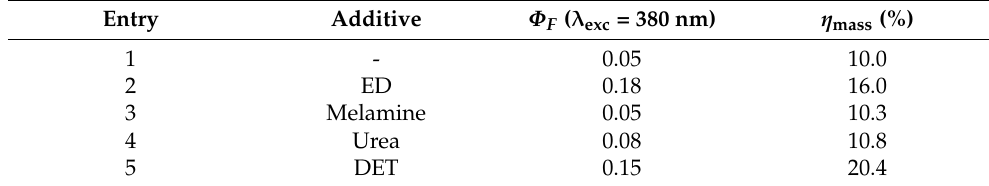
Table 3. Dependence of C-dots’ luminescence and reaction yield on additives 1